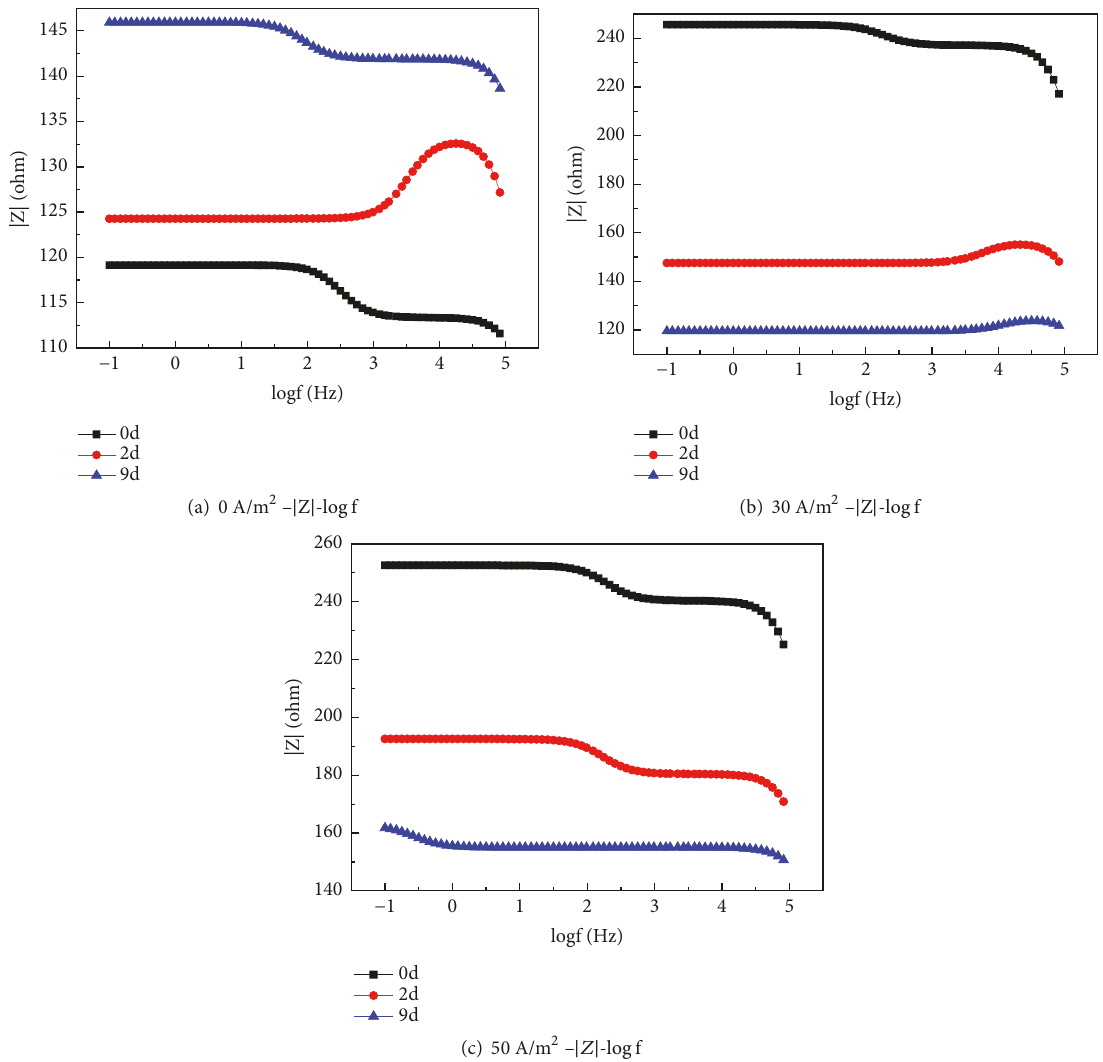
Figure 8: Bode plots under different AC current